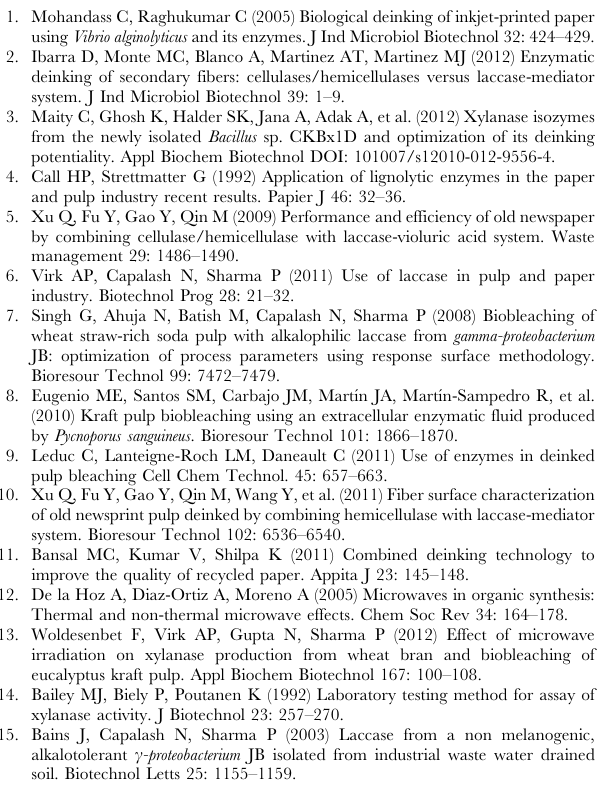
Figure S2 3D graph of combined effects of (A) Time and Enzyme dose (B) Time and pH (C) Enzyme dose and pH, on brightness when third factor was kept constant and its optimal level for laccase treatment. (TIF) Figure S3 Wavelength scan results for chemically treated (1), laccase treated (2) and untreated (3) ONP pulp. (TIF) Table S1 Experimental range and levels of independent test variables used in central composite rotary design for optimization of deinking of ONP pulp with xylanase or laccase. Table S2 Central composite rotary design matrix with experimental values of brightness for optimization of pH, incubation time and enzyme dose for deinking of ONP pulp using xylanase and laccase enzymes. Table S3 Response surface quadratic model analysis of variance (ANOVA) for deinking of ONP pulp using xylanase and laccase